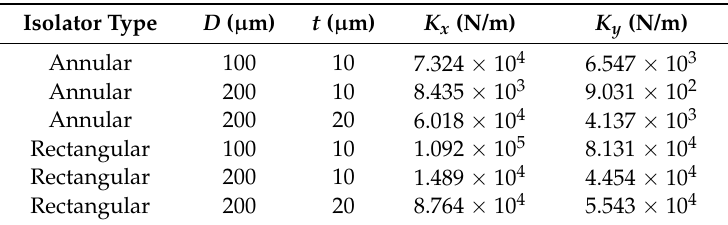
Table 1. Simulation values of the isolator